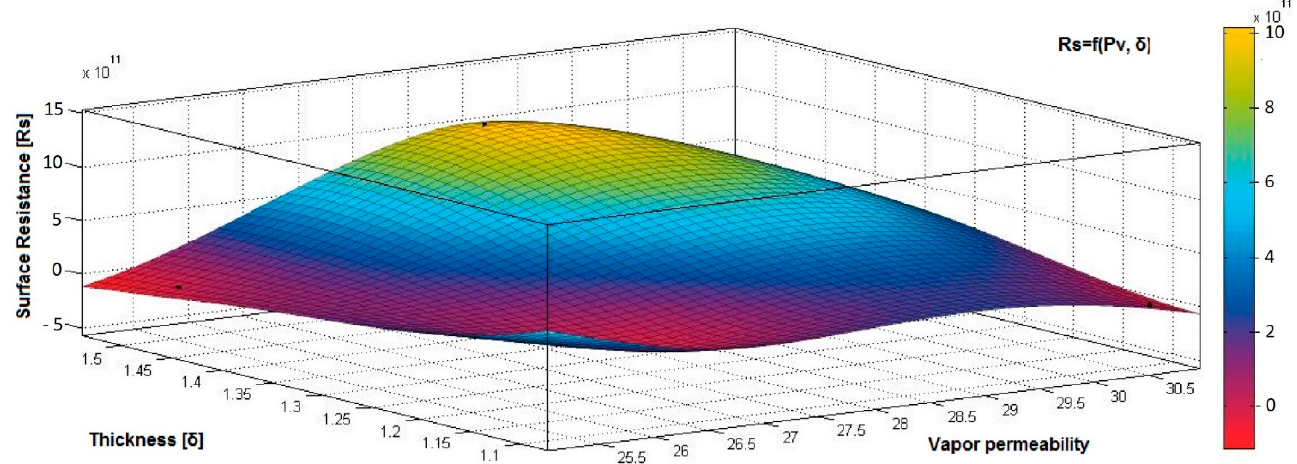
Figure 17. 3D representation Rs = f( δ , Pv ) samples coated with a conductive polymeric paste-based PVDF.